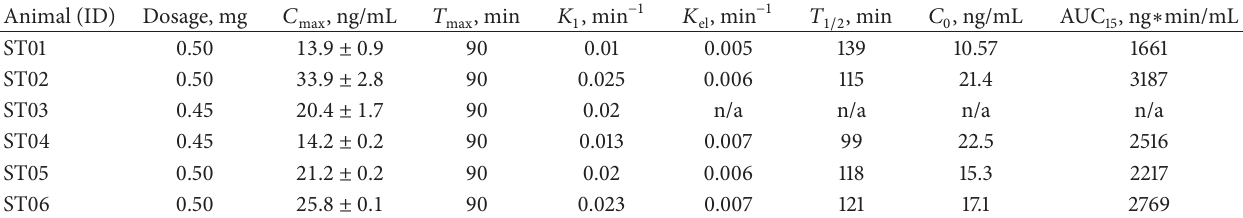
method for detection and quantitation of stepharine in rabbit plasma after intramuscular administration and designed pharmacokinetic model. The extraction of stepharine from plasma samples was optimized and yielded more than 66% of stepharine. The identity of the parent drug extracted from plasma was confirmed by high resolution Q-TOF (quadrupole time-of-flight) and quantitative analysis was assessed by selected reactions monitoring on QQQ mass spectrometers by three characteristic transitions (298.4 → 161.2, 192.1, 238.2) of stepharine protonated precursor ion. Calibration curve of stepharine peak areas against its con- centration was plotted in the range from 0.001 𝜇 g/mL to macokinetics data suggested that stepharine exhibits exten- sive distribution and rapidly cleared from the